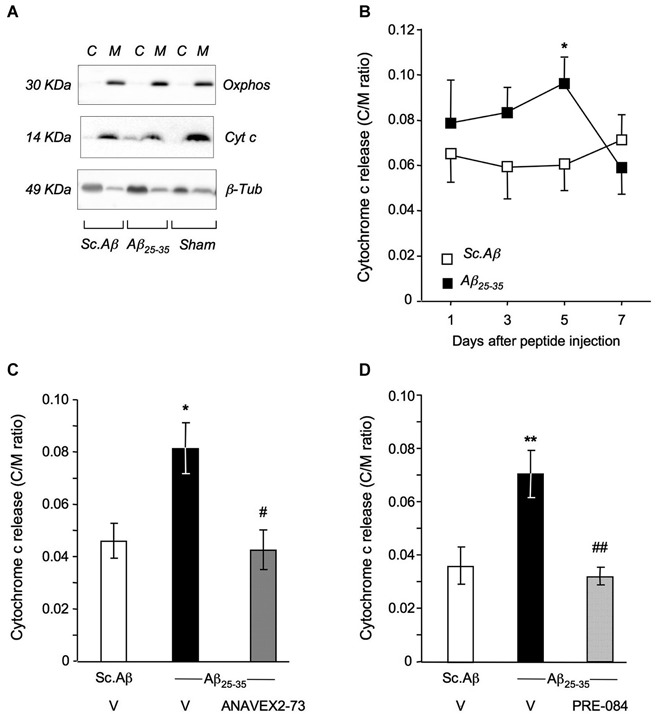
ANAVEX2-73 and PRE-084 prevented Aβ25–35-induced cytochrome c release. (A) Typical blots of mitochondrial (M) and cytosolic (C) fractions with cytochrome c, oxphos and β-tubulin antibodies. (B) Cytochrome c content (cytosol to mitochondrial content ratios). Mice were injected with Sc. Aβ or Aβ25–35 (9 nmol ICV) and sacrificed at indicated days. n = 9–12 per group. * p < 0.05 vs. Sc. Aβ. Student’s t-test. (C, D) Mice were treated with ANAVEX2-73 (0.3 mg/kg IP) or PRE-084 (0.5 mg/kg IP) before Aβ25–35 and sacrificed after 5 days. n = 8–17, F(2,37) = 5.96, p < 0.01 in (C); n = 8–14, F(2,33) = 8.19, p < 0.01 in (D). *p < 0.05, **p < 0.01 vs. Sc. Aβ, #p < 0.05, ##p < 0.01 vs. Aβ25–35; Dunnett’s test.